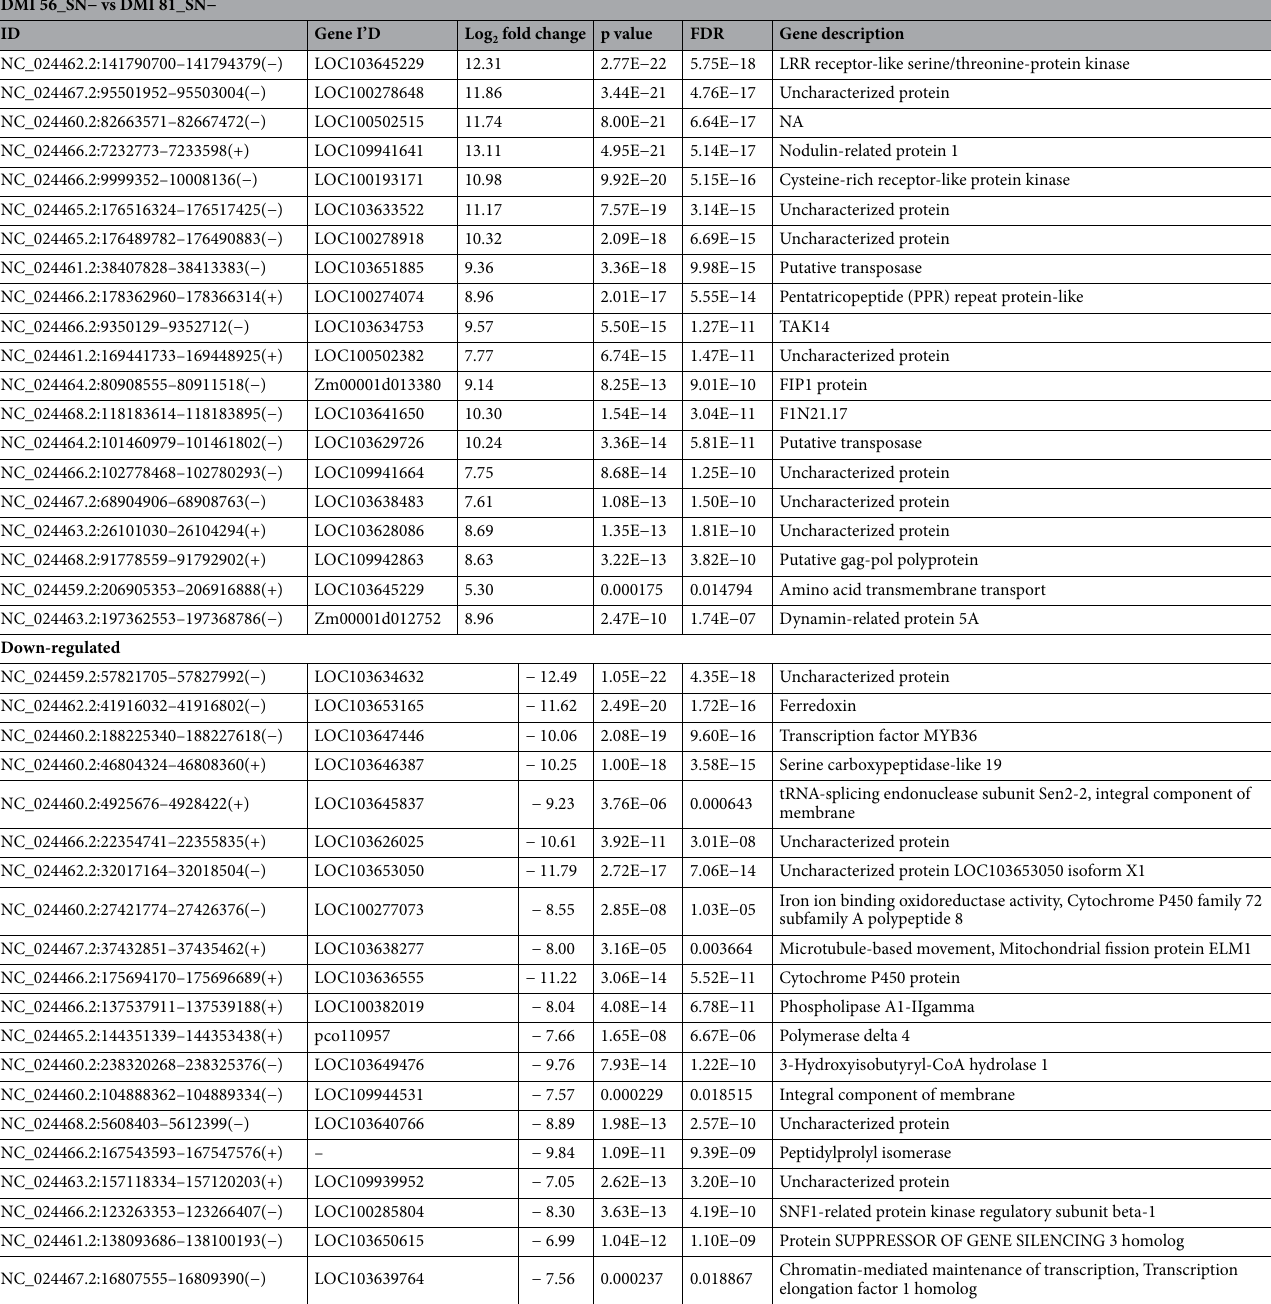
Table 4. Selected top 20 up- and down-regulated genes in DMI 81 leaf as compared to DMI 56 leaf under low-nitrogen stress (DMI 56_SN− vs DMI 81_SN−). Letters S, and N− represent leaf, and nitrogen-deficiency conditions,